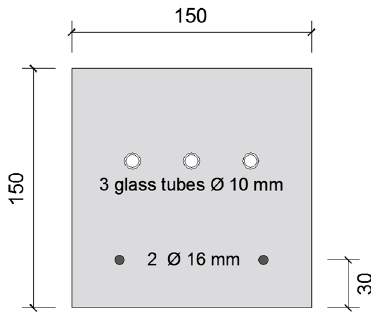
Figure 7. Cross-section of water permeability specimen (dimensions in mm).